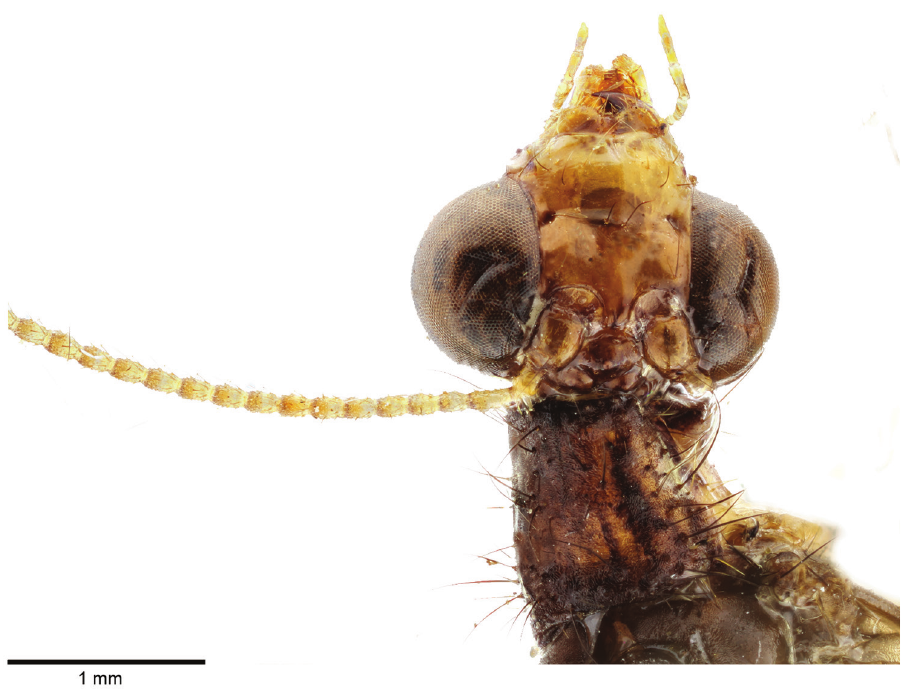
Figure 3. Spilosmylus spilopteryx sp. n. detail of the head and prothorax. clearly basal to the first branch of Rs. Forewing membrane with a diagnostic pattern composed by: a basal large, oval brown marking present at forewing middle length, a median elongated marking curved outward in proximity of the internal gradates and an apical elongated marking curved inward covering the external gradates (Fig. 2A). The latter marking is slightly more contrasted than the other two marks. MP, CuA, CuP and anal veins shaded with dark brown and with darkened crossveins. The apex of most veins reaching the hind margin is darkened. Embossed spot absent. Hind wing relatively broad. Sc and R yellowish, with intermittent, parallel, black dashes. Subcos- tal area yellowish like in the forewing but the rest of the membrane is unmarked with the exception of a few slightly shaded veins along the hind margin (Fig. 2A).